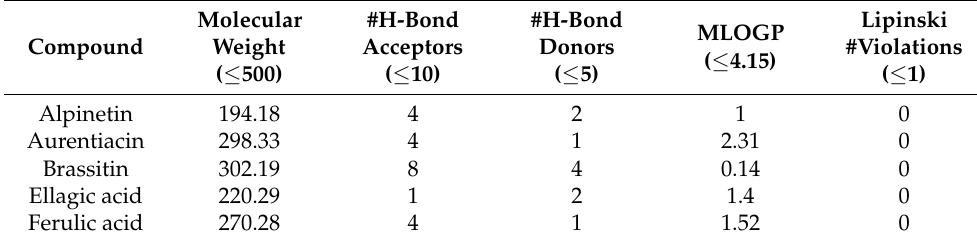
Table 5. Prediction of drug-likeness of candidate ligands by Lipinski’s rule of five parameters.